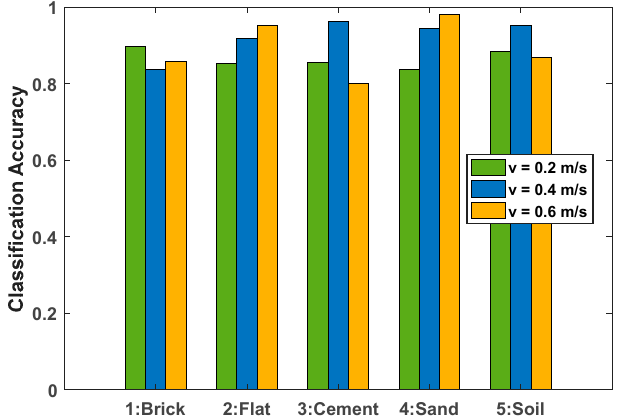
Figure 10. Classification accuracy of five types of terrain at different speeds.